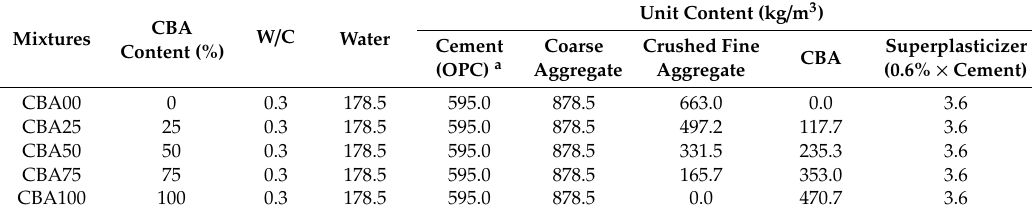
Table 3. Mixing proportions of the CBA